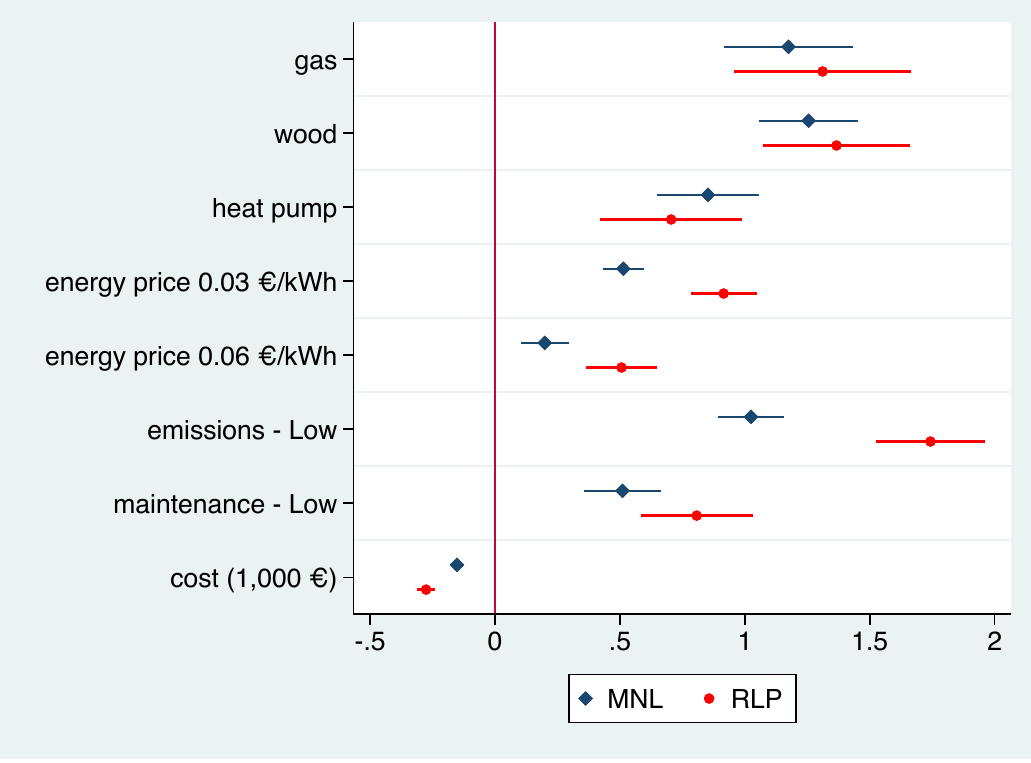
Figure 2. Comparison of the DCE, Multinomial logit (MNL) and random parameter logit (RPL) models’ estimated coefficients.